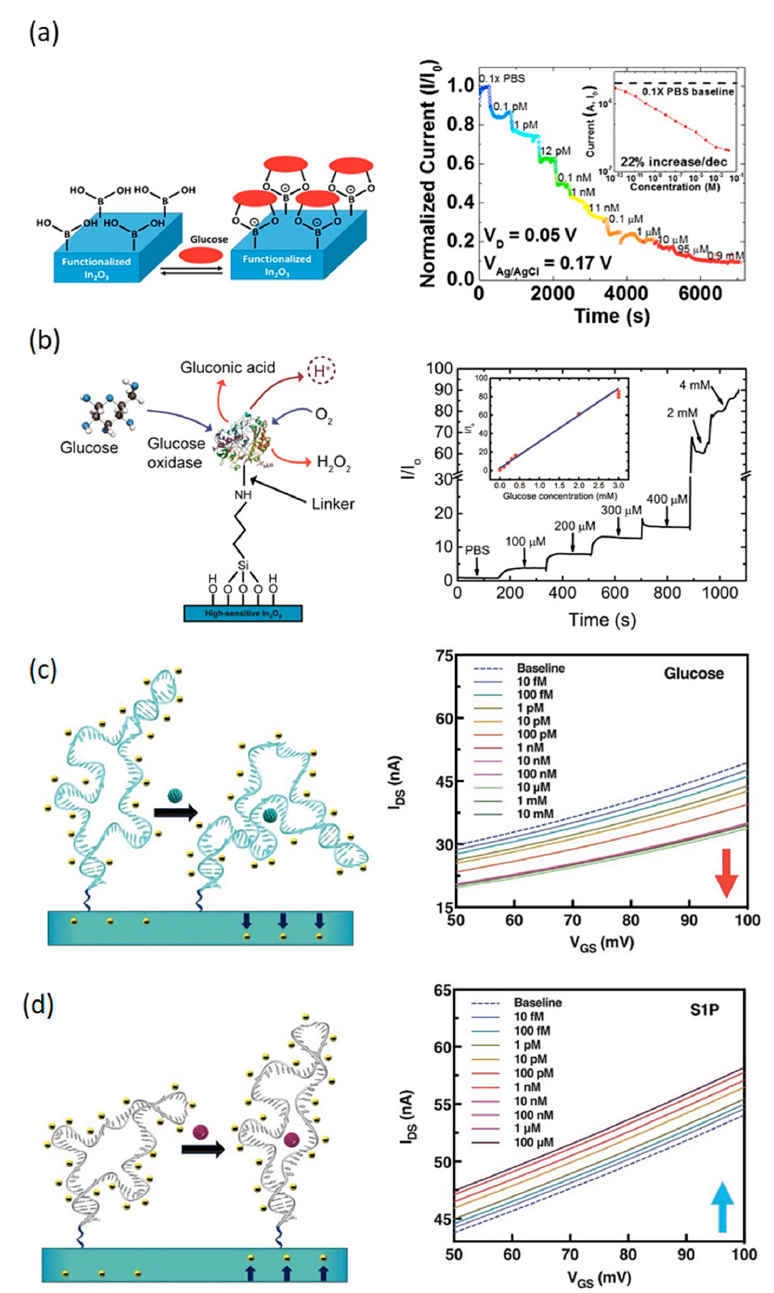
Figure 7. Schematic of In 2 O 3 FET biosensors. ( a ) Illustration of the principle of glucose sensing on boronic acid-functionalized surface and responses to various concentrations of glucose [46]. Reprinted with permission from ref [46]. Copyright 2017, American Chemical Society. ( b ) Illustration of D-glucose sensing via glucose oxidase to produce gluconic acid and hydrogen peroxide (left), and responses to physiologically relevant D-glucose concentrations (right) (inset shows data from five devices) [47]. Reprinted with permission from ref [47]. Copyright 2015, American Chemical Society. Mechanism of aptamer target-induced reorientations within or near the Debye length of semiconductor channels. ( c ) Aptamers reorient closer (e.g., dopamine, glucose) to decrease transconductance (left). Transfer curves of glucose aptamer–FETs showed reductions in source-drain currents (right), ( d ) Aptamers reorient away from semiconductor channels (e.g., serotonin, S1P) to increase transconductance (left). Transfer curves of S1P aptamer–FET transfer curves increased in response to target concentrations (right). Reprinted with some changes from ref [115]. Reprinted with permission from ref [115]. Copyright 2018,